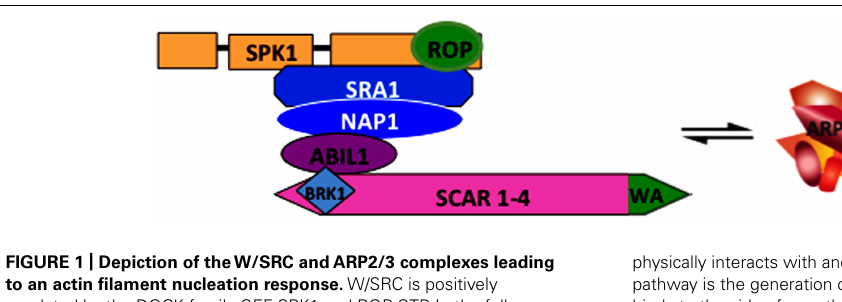
FIGURE 1 | Depiction of theW/SRC andARP2/3 complexes leading to an actin filament nucleation response. W/SRC is positively regulated by the DOCK-family GEF SPK1 and ROP-GTP. In the fully activated state theWA domain (colored green) of SCAR proteins